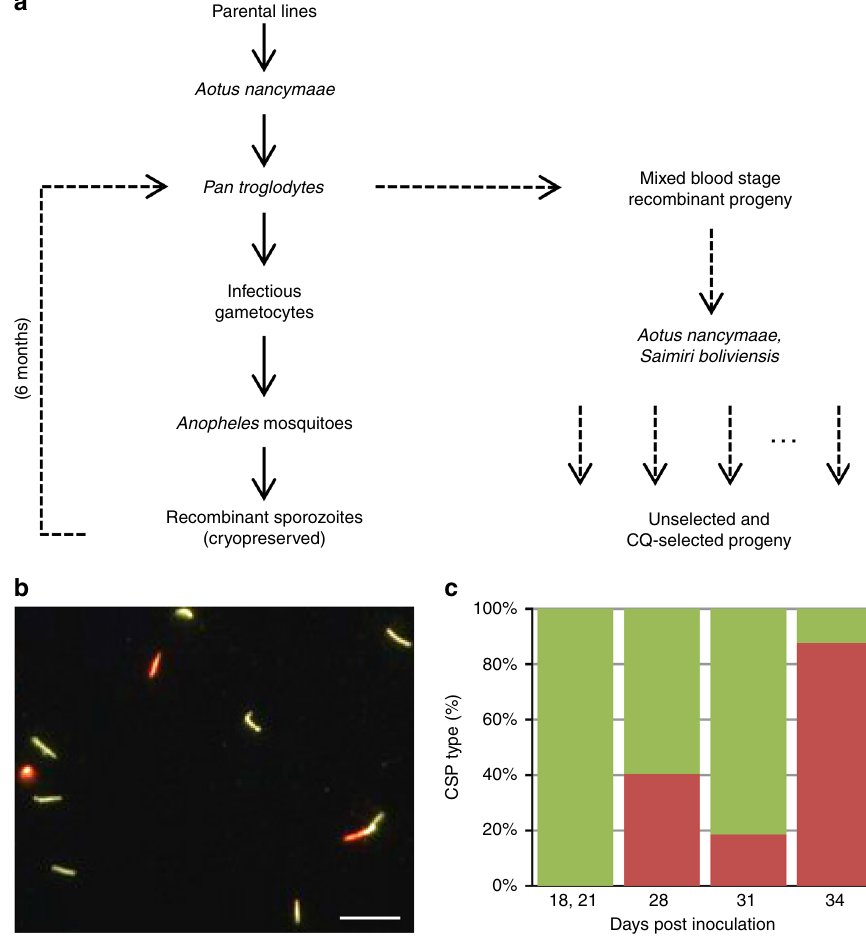
Fig. 1 Steps in the production of a P. vivax genetic cross and generation of recombinant progeny. a Work fl ow of the cross. Blood-stage parasites of P. vivax parental lines were collected from Aotus monkeys and co-inoculated into a Pan troglodytes chimpanzee. After development of parasitemia, chimpanzee blood samples containing infectious gametocytes were fed on multiple occasions to Anopheles mosquitoes to allow cross-fertilization of parental lines. Recombinant sporozoites from mating events were recovered from the mosquitoes and cryopreserved, and the chimpanzee was treated to eliminate any remaining P. vivax parental parasites. The recombinant sporozoites were inoculated into the chimpanzee 6 months after cure of parental lines infection to recover mixed blood-stage progeny from the cross. Pools of recombinant progeny were collected and sub-inoculated into Aotus and Saimiri monkeys for phenotypic characterization and genetic analysis. Solid arrows indicate the fi rst chimpanzee infection inoculated with blood-stages from the parental lines, and dotted arrows the second infection with recombinant progeny sporozoites. b Immuno fl uorescence assays were performed on recombinant sporozoites with antibodies speci fi c for the VK210 and VK247 versions of P. vivax CSP expressed by distinct parental lines. Sporozoites expressing P. vivax CSP VK210 type are represented in green and sporozoites expressing VK247 are represented in orange. Scale bar indicates ~25 µ m. c Percentages of P. vivax sporozoites expressing CSP VK210 and VK247 in the infected mosquitoes. Four batches of cryopreserved sporozoites were obtained from An. stephensi , An. freeborni , An. dirus , and An. gambiae m osquitoes fed 18, 21, 28, 31, and 34 days after the co-inoculation (sporozoites from 18 and 21 feedings were combined and presented in the fi rst bar). The chimpanzee was treated with a low dose of CQ (2.7 mg/kg) on day 21 to increase CQ-R P. vivax parental population carrying the VK247 marker and improve chances of cross-fertilization over self-mating events in the Supplementary Table 7). HPLC-mass spectroscopy of plasma increased to 0.01% in thin blood fi lms 43 DPSI. After an addi- samples from these monkeys con fi rmed therapeutic CQ levels tional 3-day CQ treatment of 2.5 mg/kg/day beginning 53 DPSI, ( ≥ 10 ng/mL) 2 , with a single exception (Supplementary Table 8). parasites were detectable by PCR until fi nal cure at 102 DPSI with Malarone plus primaquine; follow-up PCR testing con fi rmed no remaining infection after one year. Linkage-group selection maps a chromosome 1 determinant . Infected blood from each monkey before CQ administration (NIH-1993 S × R unselected progeny) and after recrudescence (selected progeny) provided 10 sample pairs for linkage group selection analysis (LGS) 19 . Quantitative inheritance signals were obtained from these LGS pairs by PCR with 37 polymorphic microsatellite markers distributed irregularly across the 14 P. vivax chromosomes (Supplementary Fig. 5). CQ selection E values displayed by heat map (Fig. 2a, Supplementary Table 9), Fig. 4,